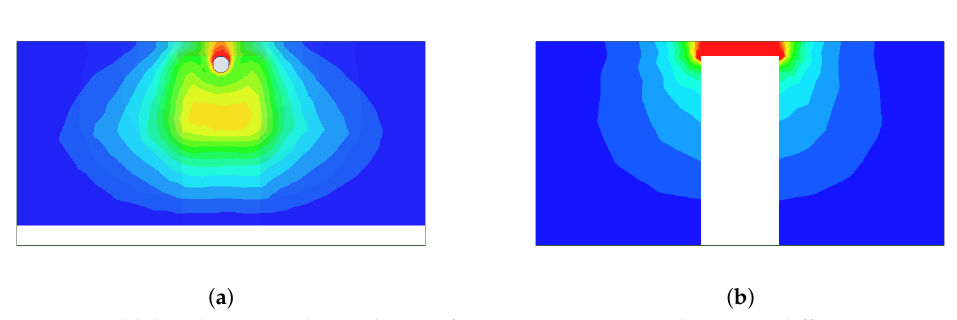
Figure 3. Field distribution in the mode transformation (in magnitude) at two different transverse sections. The white areas are metal filled. With reference to the Figure 2: ( a ) Electric field of the TEM mode on the cross-section at center of the l p long step where the coaxial pin penetrates in the WG; ( b ) Electric field of the TE 10 mode on the cross-section at the center of l r long ridged WG